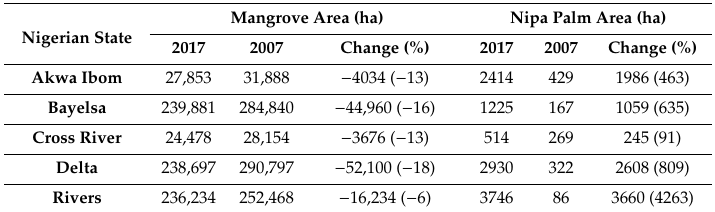
Table 7. Area of Mangrove and Nipa Palm in Niger Delta States and Change in Land Cover Classes from 2007 and 2017 over the region.